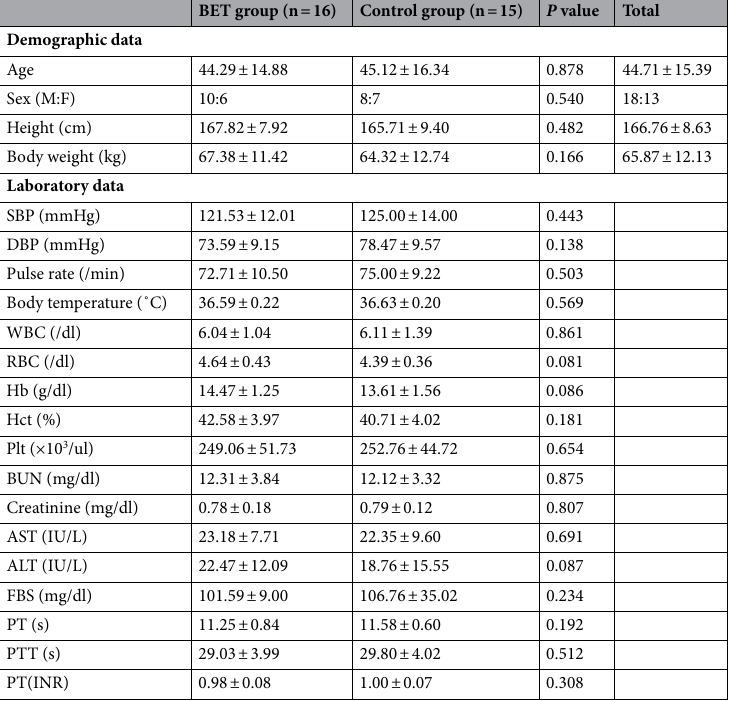
Table 2. Patients baseline demographic characters and results of laboratory tests. ALT, alanine aminotransferase; AST, aspartate aminotransferase; BUN, blood urea nitrogen; DBP, diastolic blood pressure; FBS, fasting blood sugar; Hb, hemoglobin; Hct, hematocrit; INR, international normalized ratio; Plt platelet, PT prothrombin time; PTT, partial thromboplastin time; RBC, red blood cell; SBP, systolic blood pressure; WBC, white blood cell.